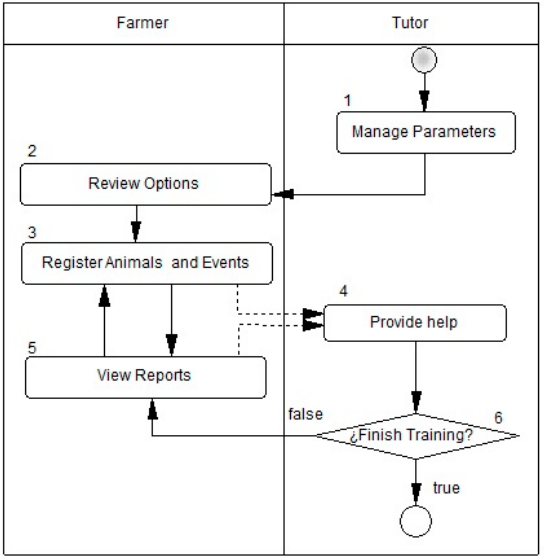
Figure 8. Steps of phase 7-Training with DSS on a real farm